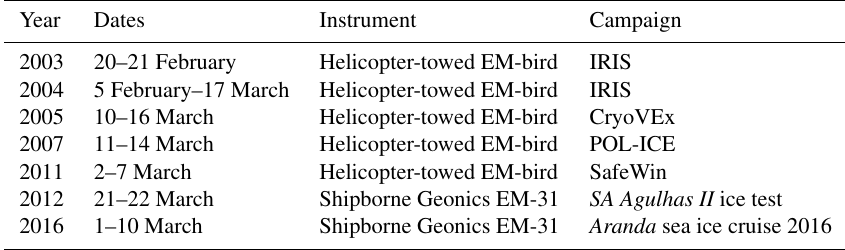
Table 1. Summary of helicopter and ship-based EM data used in this